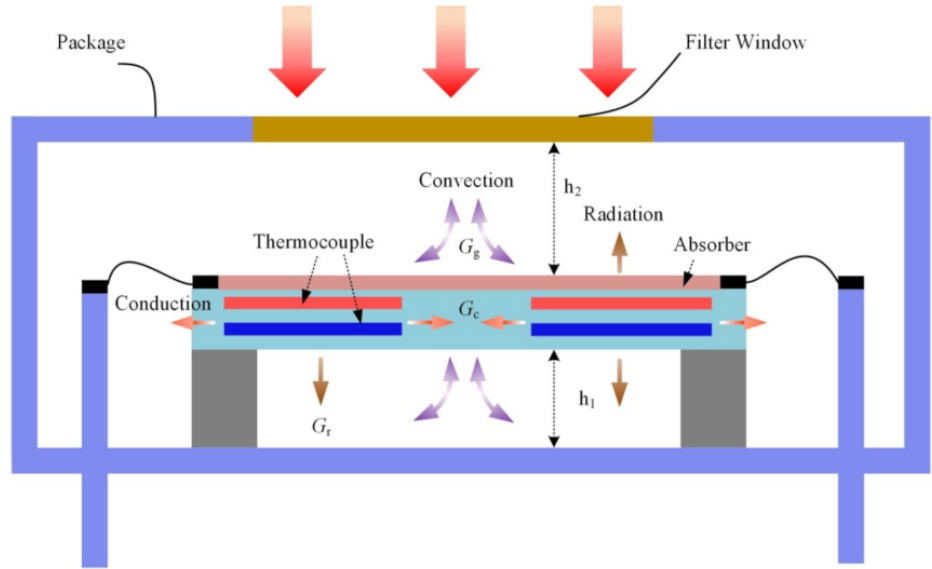
Figure 7. Heat transfer (solid thermal conductance of the structure G c , convection G g , and radiation G r ) in a traditional CM-based